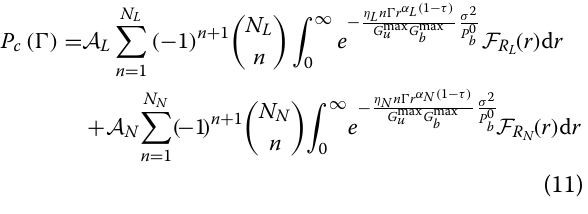
parameters defined in Section 2 . For s ∈ { L , N } , η s = − 1 N s ( N s ! ) Ns and N s are the parameters of the Nakagami small-scale